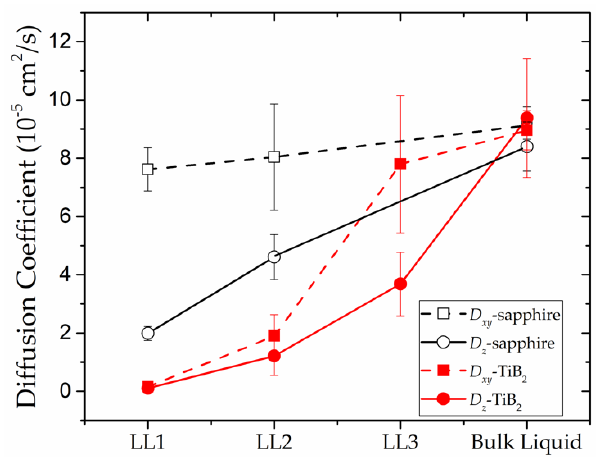
Figure 5. Out-of-plane and in-plane diffusion coefficients, 𝐷 𝑥𝑦 and 𝐷 𝑧 , of the substrate-induced liquid layers.